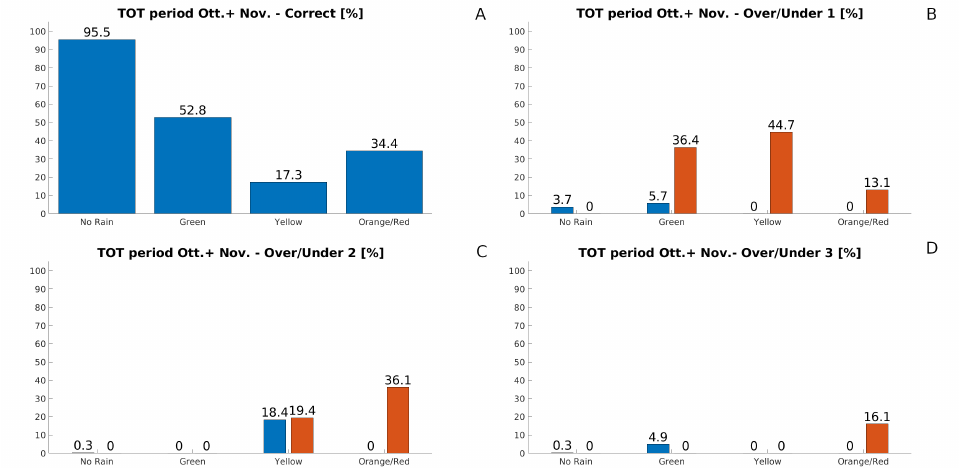
Figure 7. Performance obtained using only a single run. In panels ( B – D ), overestimations are represented in blue and underestimations are in orange, panel ( A ) represents the correct forecast per- centage.